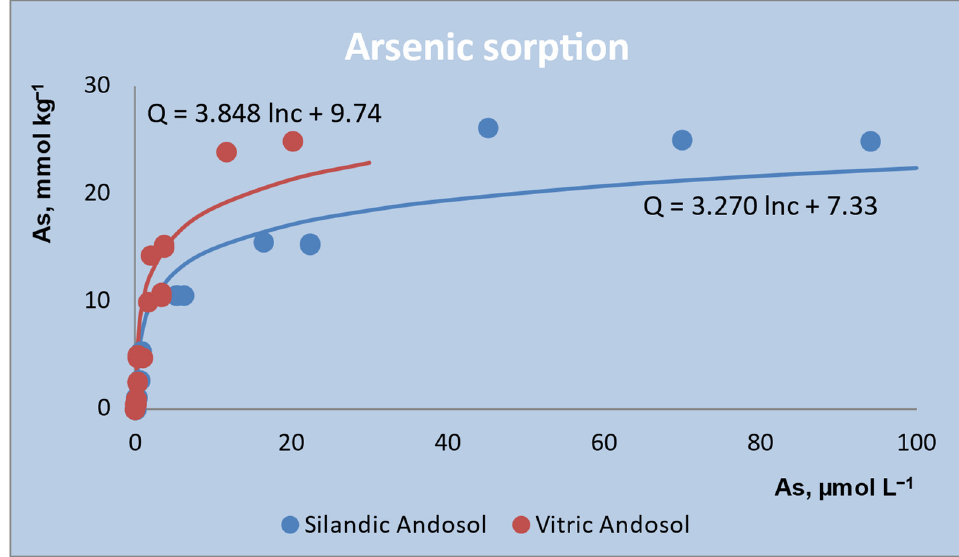
Figure 4 . As sorption isotherms (sorbed As (mmol kg − 1 ) vs. As concentration in the equilibrium solution (µmol L − 1 )) fitted to the Temkin model.